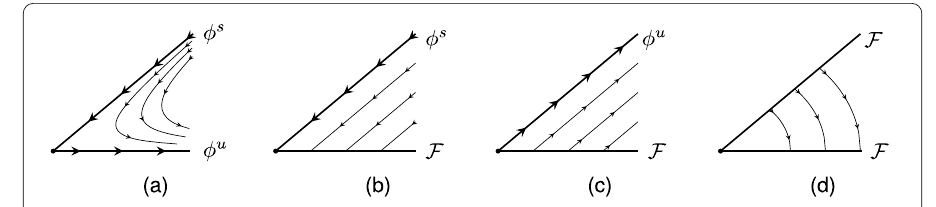
Figure 3 Illustrations of (a) a hyperbolic sector, (b) an attracting parabolic sector, (c) a repelling parabolic sector, and (d) an elliptic sector. The arrows represent the direction of the trajectories of the orbits. Here φ s and φ u are the curves in Theorem A, and F is the curve of fixed points